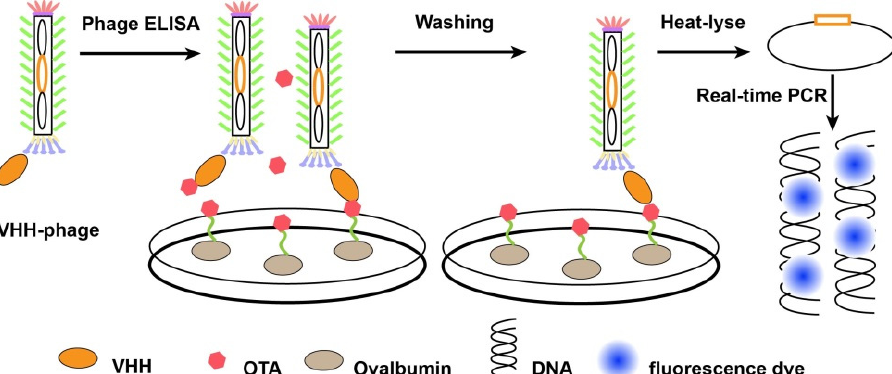
of violet and sky blue respectively means positive and negative result. The visual detection limits of iLAMP of AFB 1 , AFB 2 , AFG 1 , and AFG 2 in peanut samples were 1.6, 1.6, 3.2, and Figure 4. The process of PD-IPCR based on VHH-phage. Firstly, VHH-phages and OTA were mixed 16 µ g/kg, respectively [107]. and incubated with ovalbumin conjugated OTA pre-coated on the solid surface. Then, VHH-phages